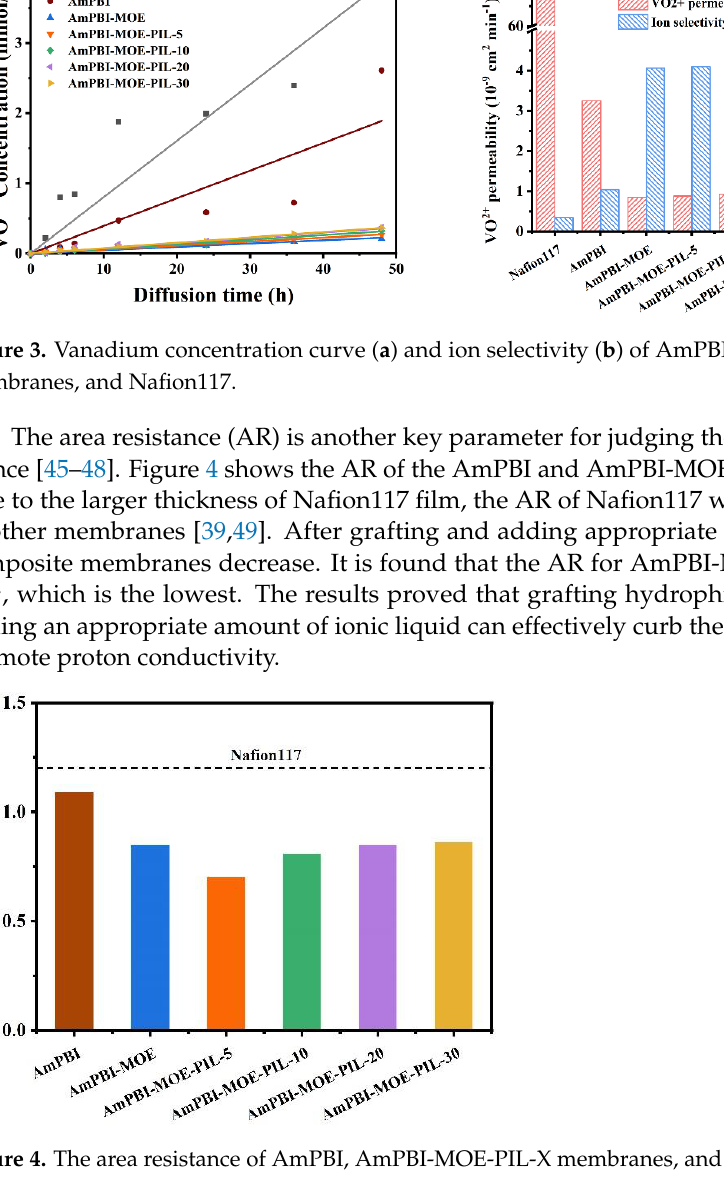
Figure 4. The area resistance of AmPBI, AmPBI-MOE-PIL-X membranes, and Nafion117.